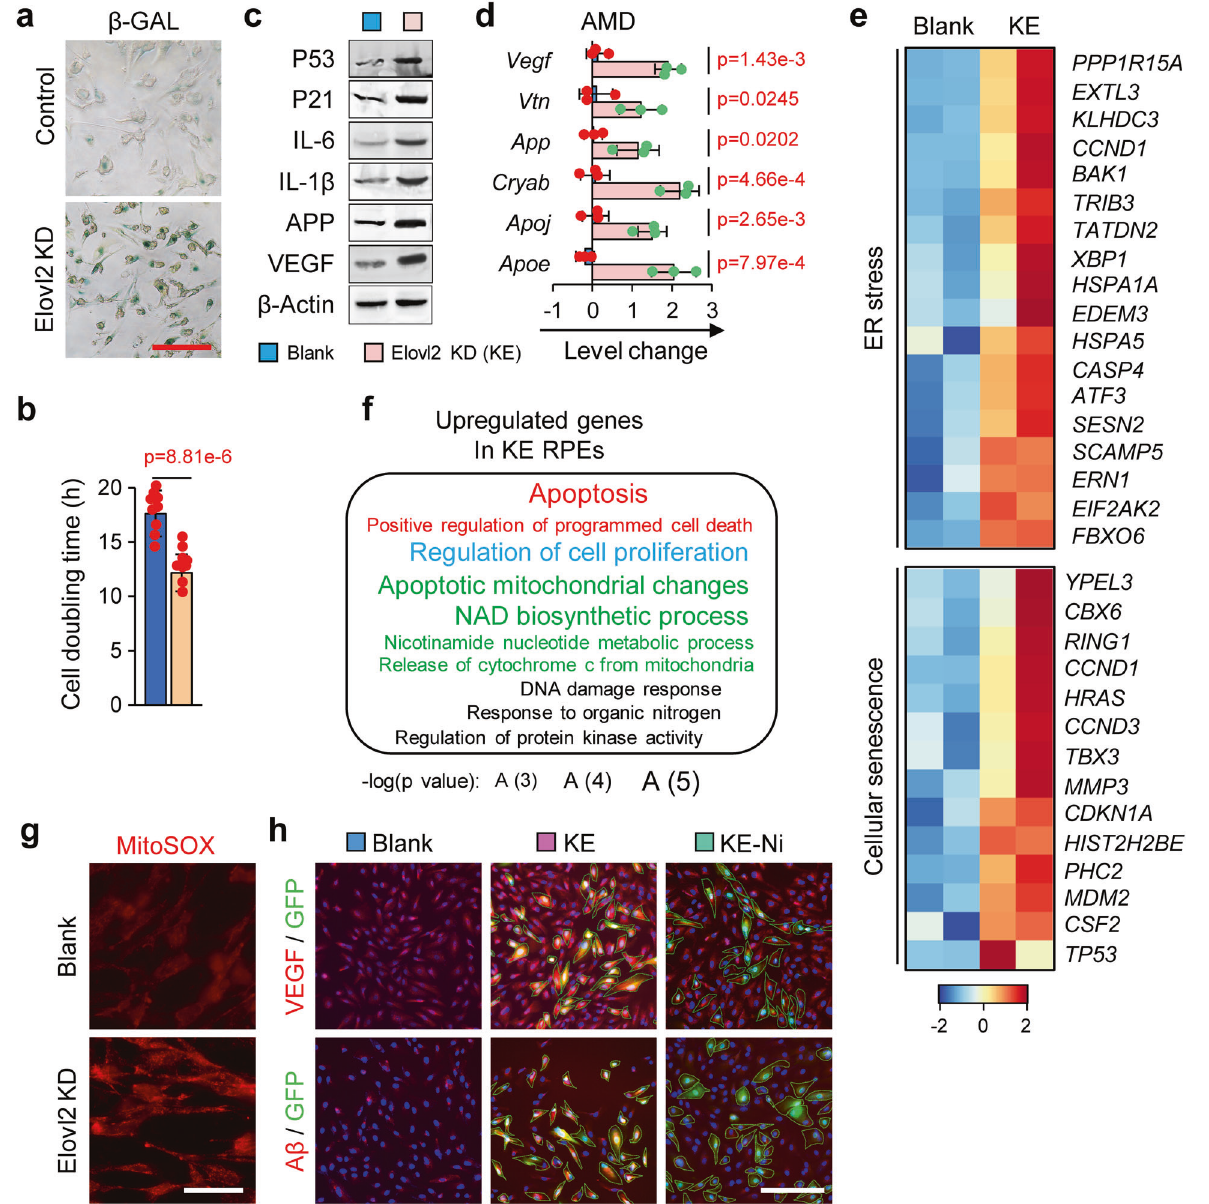
Fig. 6 AMD phenotype induced by the depletion of Elovl2 in human RPE cells. a β -galactosidase staining on human RPE cells with no treatment (Control) or Elovl2 knockdown (Elovl2 KD) ( n = 3). Scale bar, 100 µm. b Cell doubling time analysis ( n = 9). Error bars, SEM. * p < 0.05. Levels of signi fi cance were calculated with two-tailed Student ’ s t test. Western blotting ( c ) and qPCR ( d ) of senescence and AMD marker in blank and KE cells ( n = 3). * p < 0.05. Levels of signi fi cance were calculated with two-tailed Student ’ s t test. e The expression pattern of genes in ER stress- and cellular senescence-related pathways ( n = 2). f The Gene Ontology terms enriched in upregulated genes in KE RPE cells. g mitoSOX staining results ( n = 3). Scale bar, 100 µm. h Immuno fl uorescence of blank and KE RPE cells treated with nicotinamide (Ni) with VEGF and A β antibodies ( n = 3). Scale bar, 100